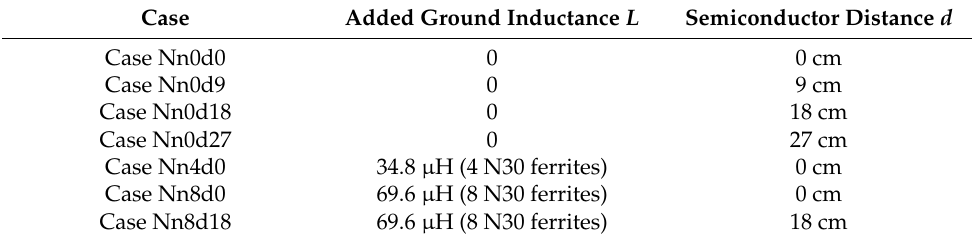
Table 2. Non-coaxial injection test